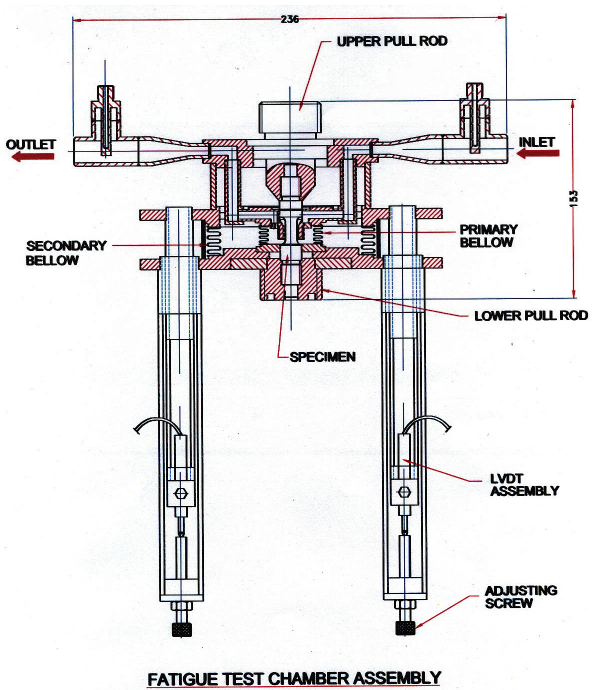
Figure 3. Details of Fatigue Test